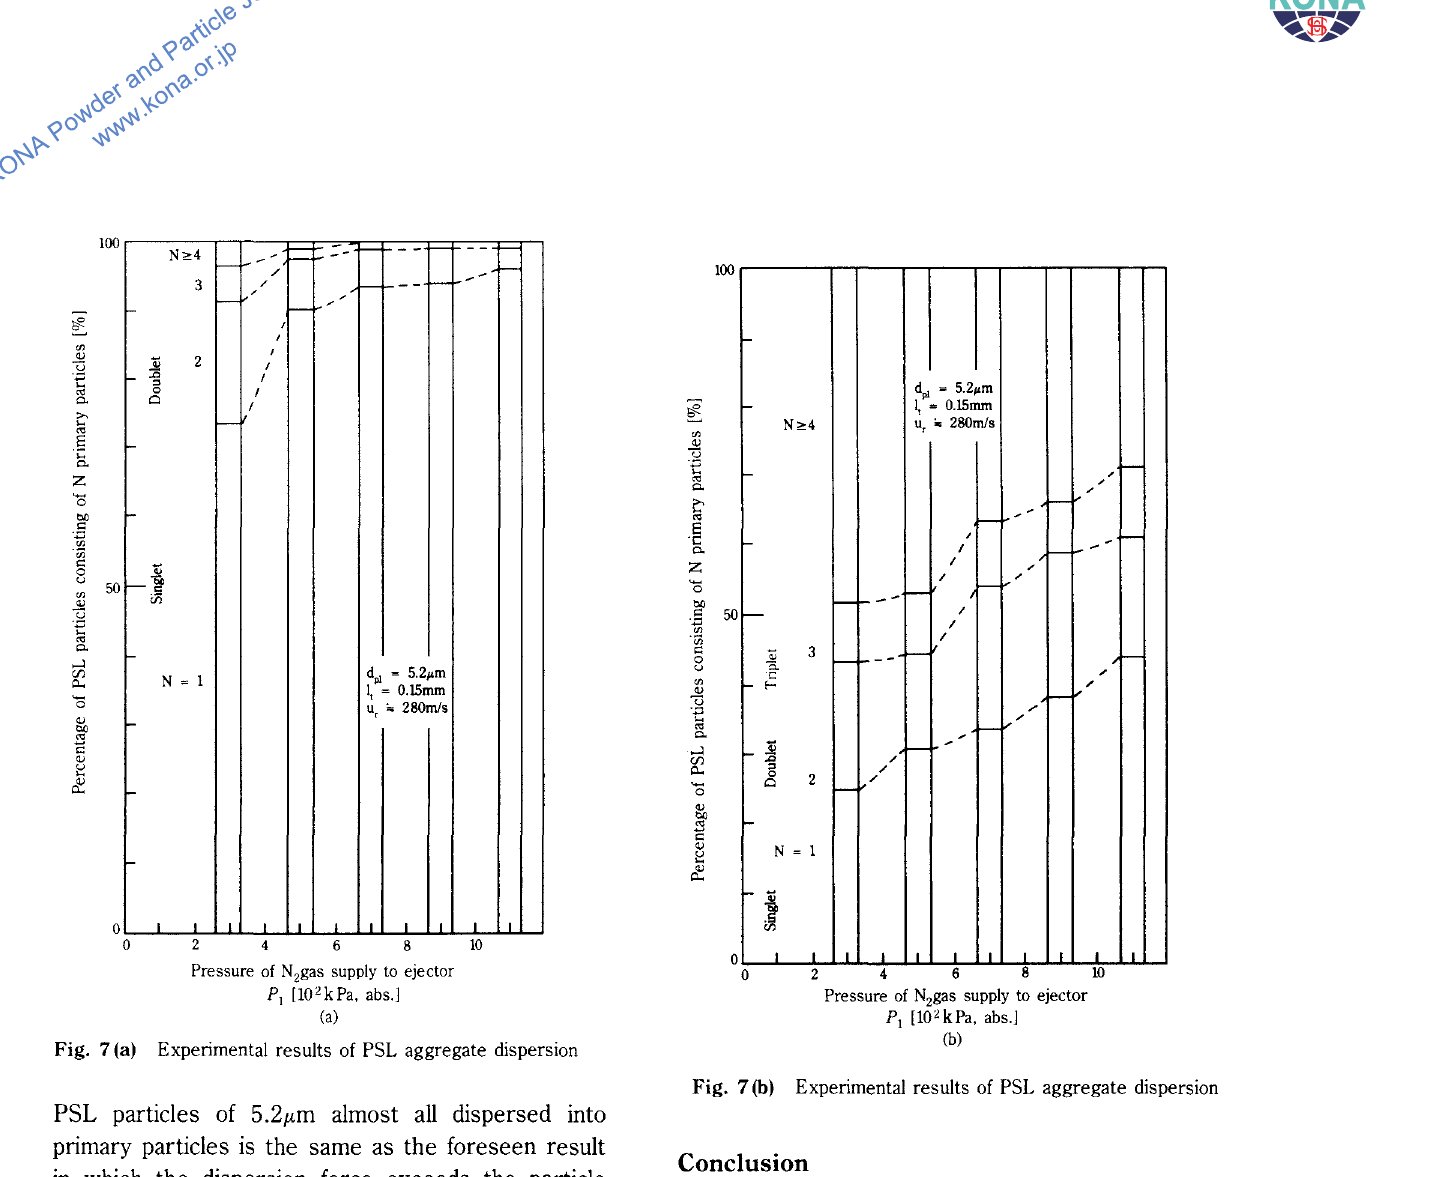
Fig. 7 (a) Experimental results of PSL aggregate dispersion